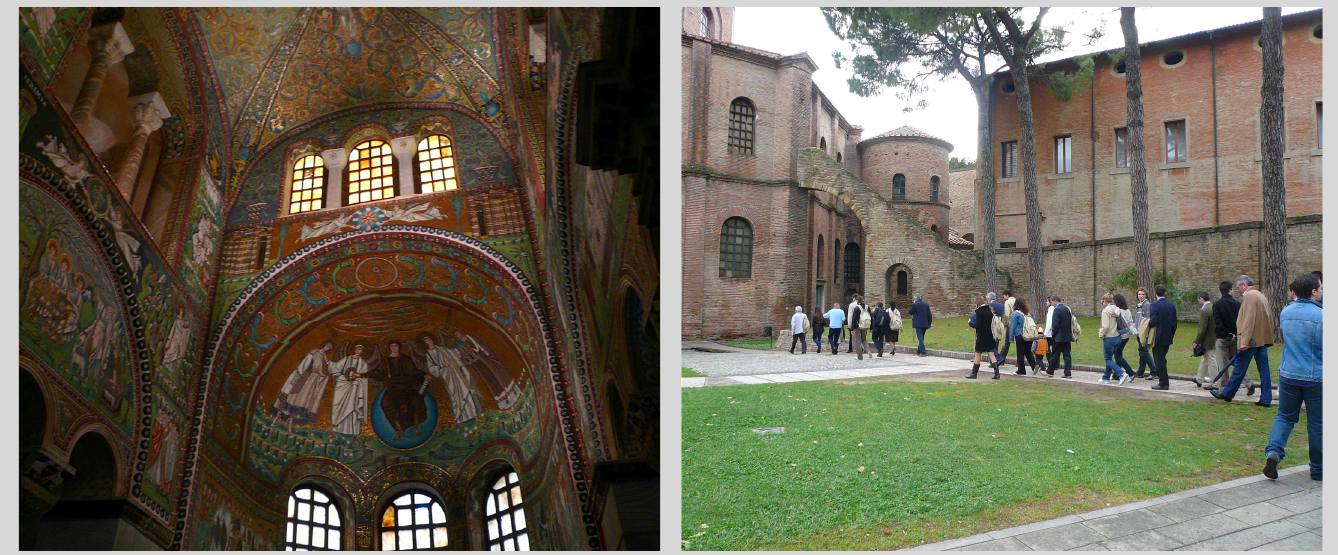
Figure 5 (left): The mosaics in the Basilica di San Vitale. Figure 6: The guided tour in